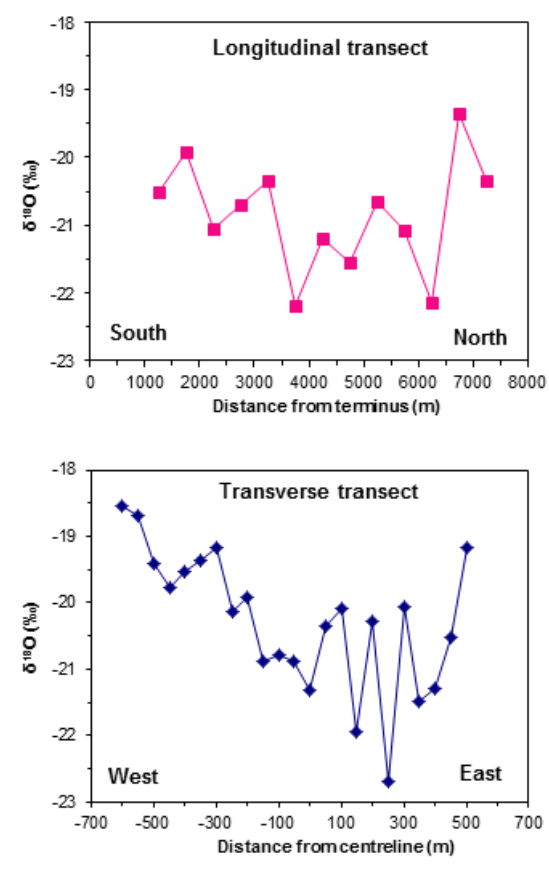
Figure 7. Variations in δ 18 O of glacier ice along a longitudinal tran- sect and a transverse transect on Kuannersuit Glacier. The trans- verse transect crosses the longitudinal transect at a distance of 3250m from the glacier